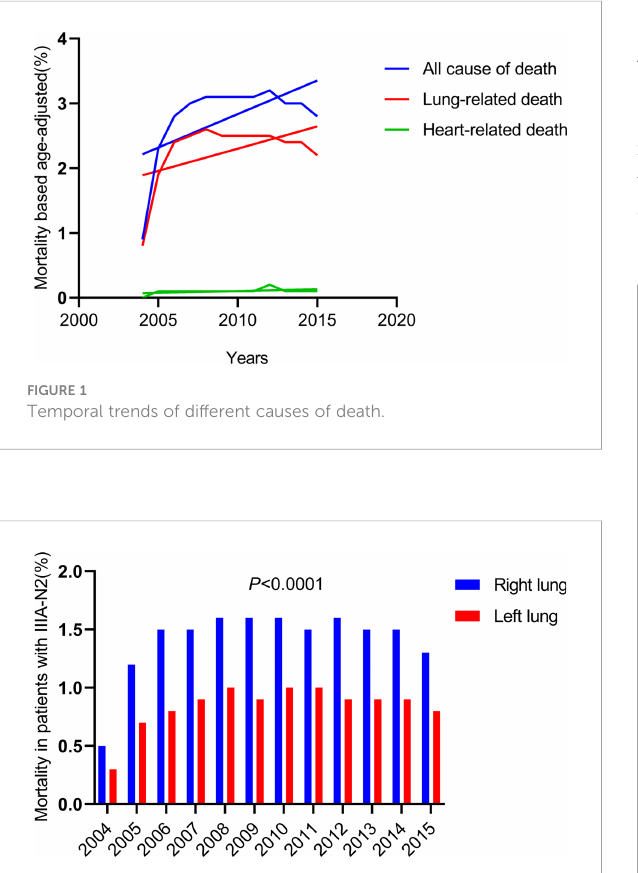
FIGURE 2 Death of different laterality in death from the lungs with IIIA-N2 stage NSCLC in 2004-2015.